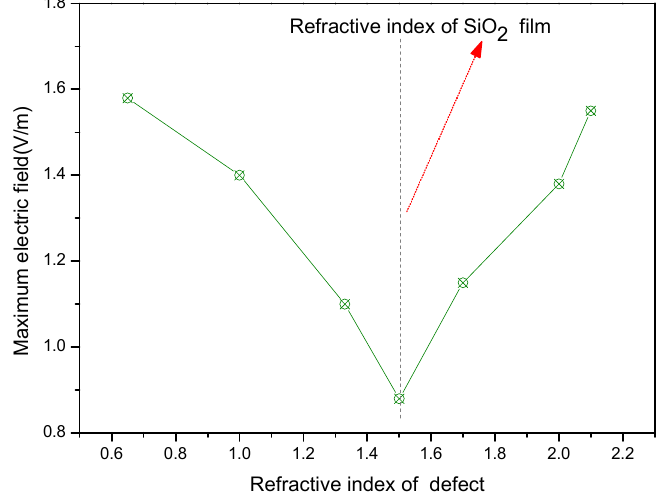
Figure 4. Light field intensification as a function of refractive index of the defect.